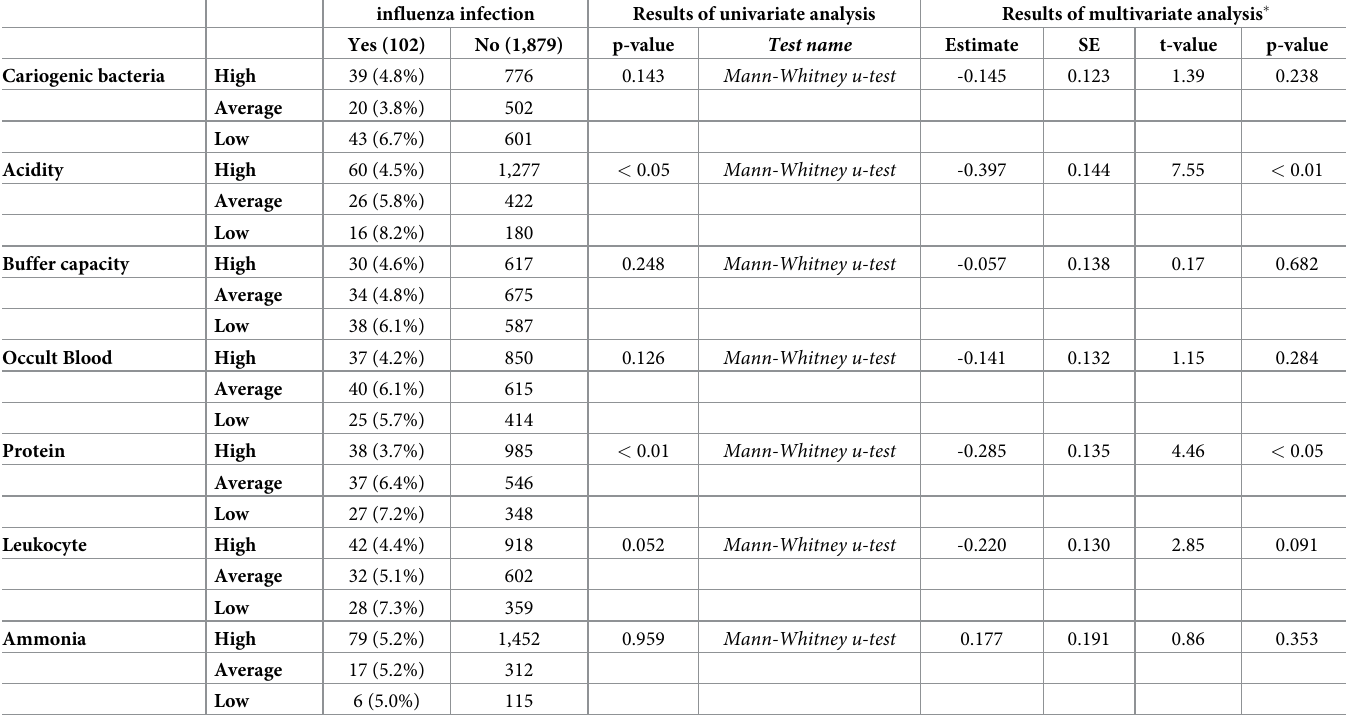
Table 4. Result of uni- and multivariate analysis assessing the correlation between influenza infection and results of salivary